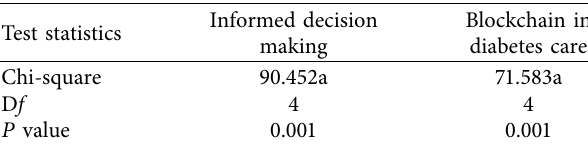
Table 6: Chi-square tests allow medical practitioners to taking informed decision making and the usage of blockchain in diabetes care for elderly